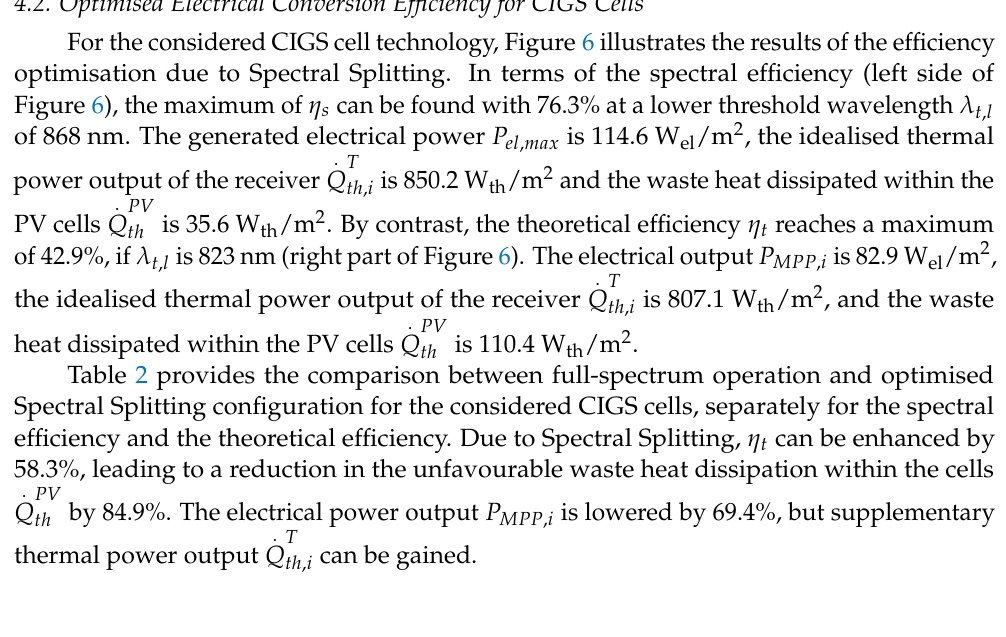
Table 1. Comparison of key parameters at full spectrum and at optimum Spectral Splitting configuration for c ‐ Si PV tech ‐ nology.